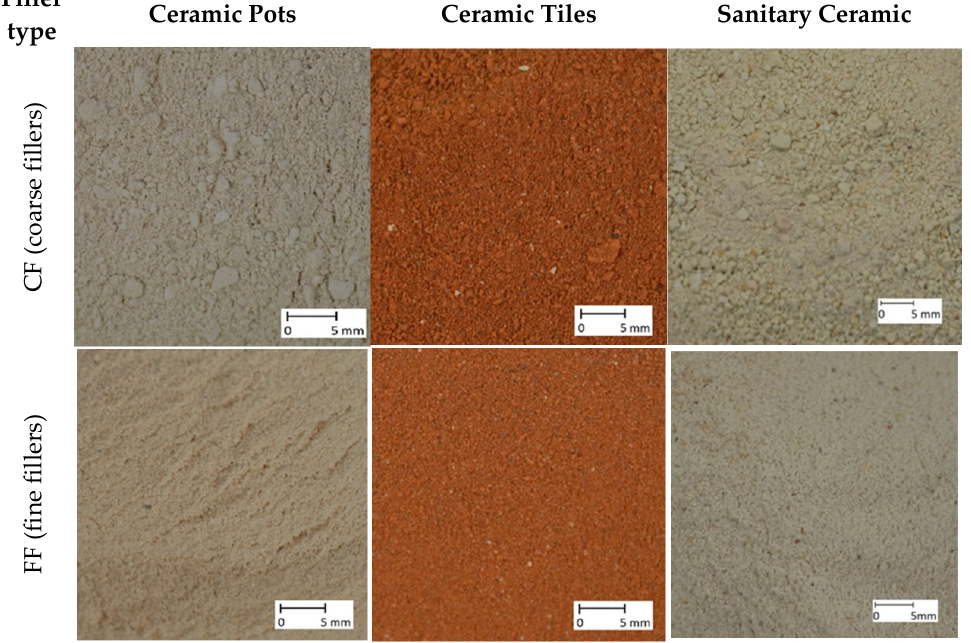
Figure 2. Optical microscope images of the used ceramic fillers of different origin. Table 2. The granular composition of the used ceramic fillers. Coarse fillers (CF) and fine fillers (FF).